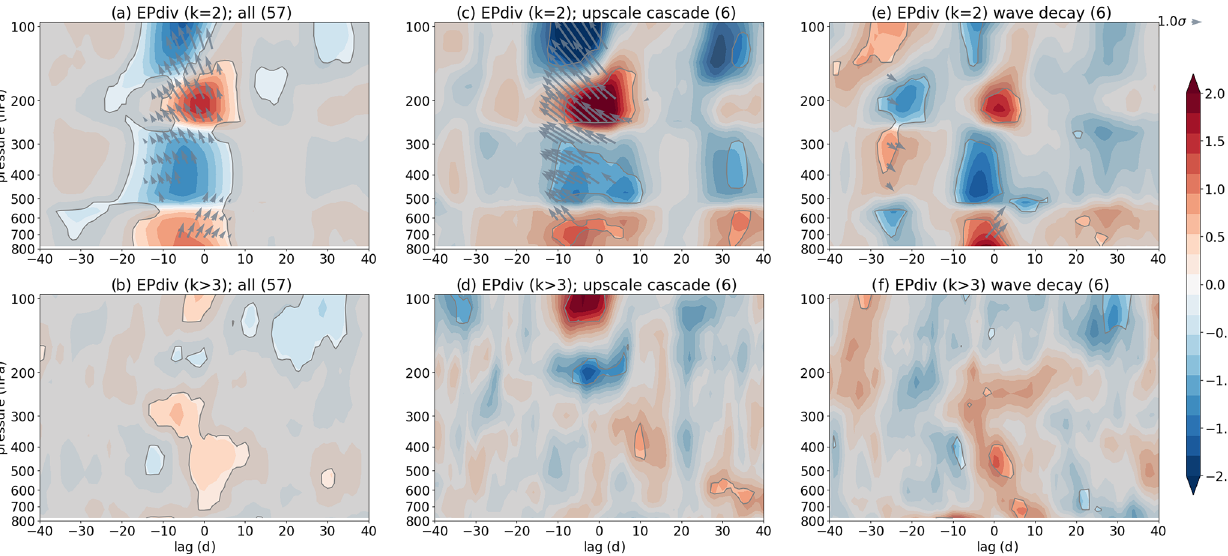
Figure 4. Composite analysis (lag–pressure for data averaged between 40 and 60 ◦ N) demonstrating the upscale cascade mechanism (based on a few subjectively identified events) (c, d) and wave decay (e, f) mechanisms, as well as a composite over all wave-source events (a, b) preceding SSDs that were objectively identified. Panels (a, c, e) show standardized k = 2 EP flux divergence anomalies (shading) and standardized EP flux anomalies (grey arrows), whereas panels (b, d, f) show standardized EP flux divergence anomalies of the synoptic- scale waves ( k ≥ 4). The arrows denote average meridional wave propagation direction (left tilt: equatorward; right tilt: poleward) and its magnification within the chosen latitudinal range at specified pressure and lag (i.e., not propagation in time), but they do not imply actual size of the EP fluxes or the propagation out of the boundaries of the latitudinal range. Grey shading masks out data that are not significant at the 95% level. EP fluxes (arrows) are only shown for values exceeding the 95% significance level. The numbers in brackets denote the number of events in each composite. Data are from the